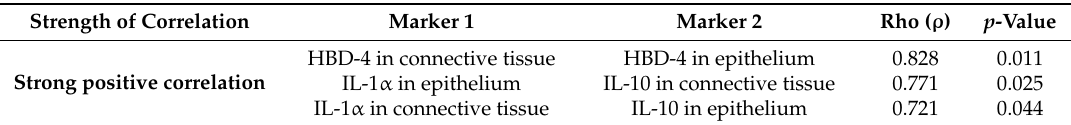
Table 3. Spearman’s rank correlation coe ffi cient revealed correlations between the relative numbers of di ff erent factors in rosacea-a ff ected epithelium and subepithelial connective tissue. Strength of Correlation Marker 1 Marker 2 Rho ( ρ ) p -Value HBD-4 in connective tissue HBD-4 in epithelium 0.828 0.011 Strong positive correlation IL-1 α in epithelium IL-10 in connective tissue 0.771 0.025 IL-1 α in connective tissue IL-10 in epithelium 0.721